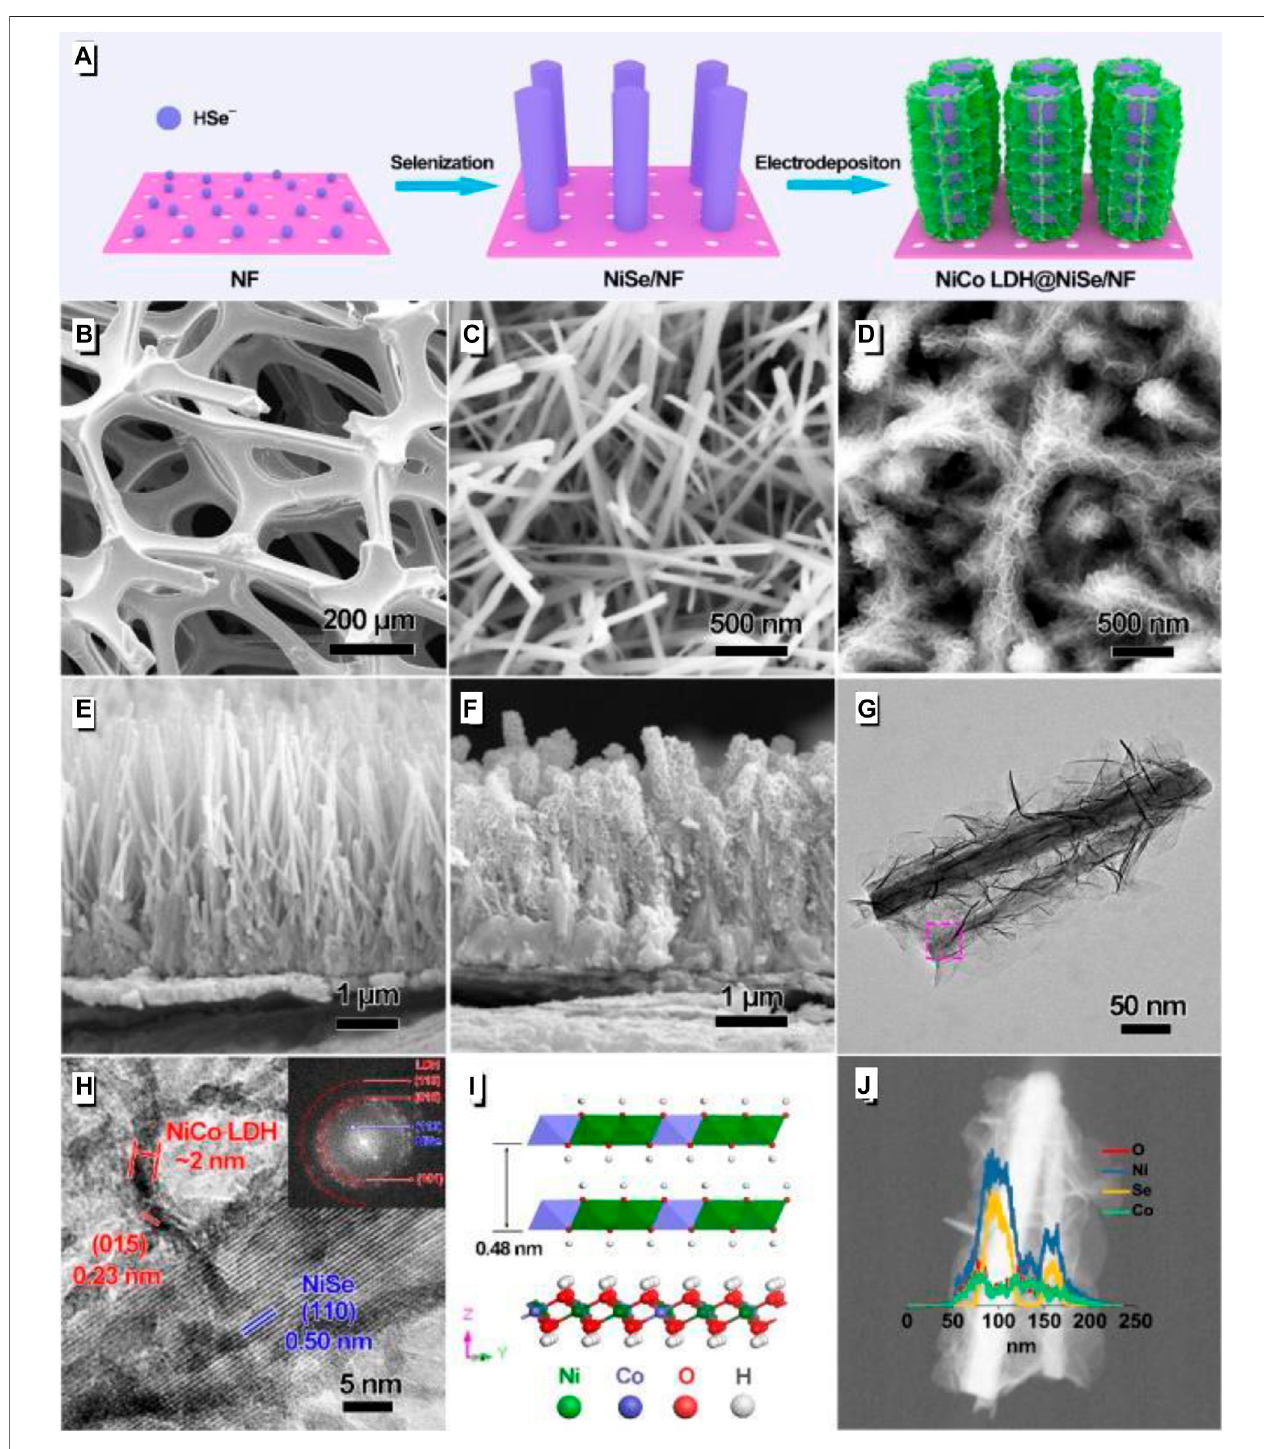
FIGURE 13 | 2 nm Thick NiCo LDH@ Nize Single-Crystal Nanorods Grown on Ni Foam as Integrated Electrode.